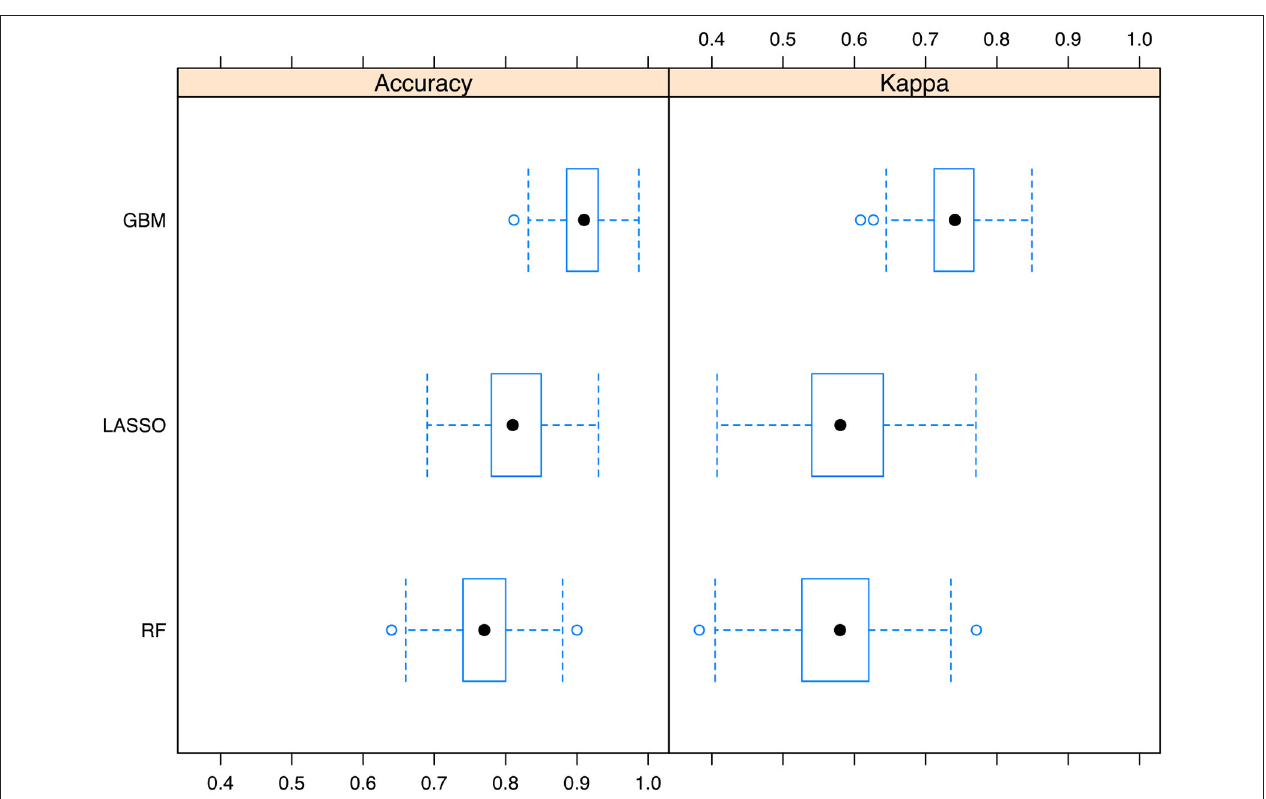
FIGURE 4 | Comparisons of the Gradient boosting machine with other models. The performance metrics of accuracy and kappa was reported. The boxplot shows the median and range of the performance metrics in resampled datasets. GBM, gradient boosting machine; LASSO, Least Absolute Shrinkage and Selection Operator; RF, random